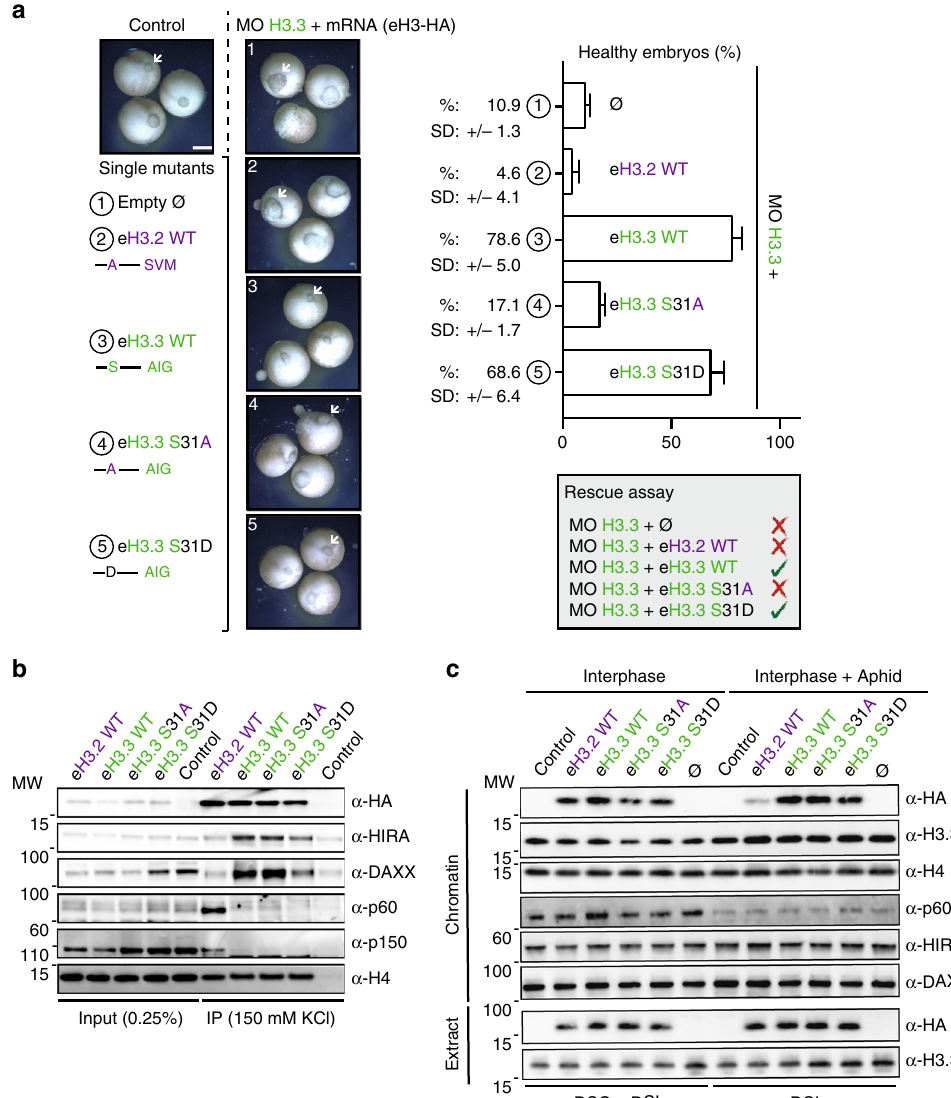
Fig. 5 H3.3 S31D phospho-mimic rescues H3.3 depletion. a Rescue assays with eH3.3 S31D mutant and controls. Injections are performed at two-cell stage. Effect on gastrulation is analyzed at stage 12. White arrowheads indicate the blastopore closure. Scale bar corresponds to 500 µ m. Bar plot shows mean ± SD for three independent experiments with more than 30 embryos. b Immunoprecipitation of eH3.3 S31 mutants from interphase extracts. Recombinant proteins are produced in rabbit reticulocyte lysates and pulled down by their HA-tag after incubation. The binding of HIRA, DAXX, p60, and p150 is analyzed by western blotting with speci fi c antibodies. α -HA antibody is used to detect eH3.3. H4 is used as an internal control. Primary antibodies indicated on the right. Molecular weight (MW) markers in kDa indicated on the left. c Incorporation of eH3 S31 mutant forms and controls into sperm chromatin in interphase extracts. Puri fi ed nuclei remodeled in the interphase extracts supplemented with indicated eH3.3 proteins in the presence or absence of aphidicolin are analyzed by western blotting with indicated antibodies. α -HA antibody is used to detect eH3.3. Primary antibodies indicated on the right. Molecular weight (MW) markers in kDa indicated on the left. DSC: DNA-synthesis coupled, DSI: DNA-synthesis independent mode of incorporation. Source data are provided as a Source Data fi